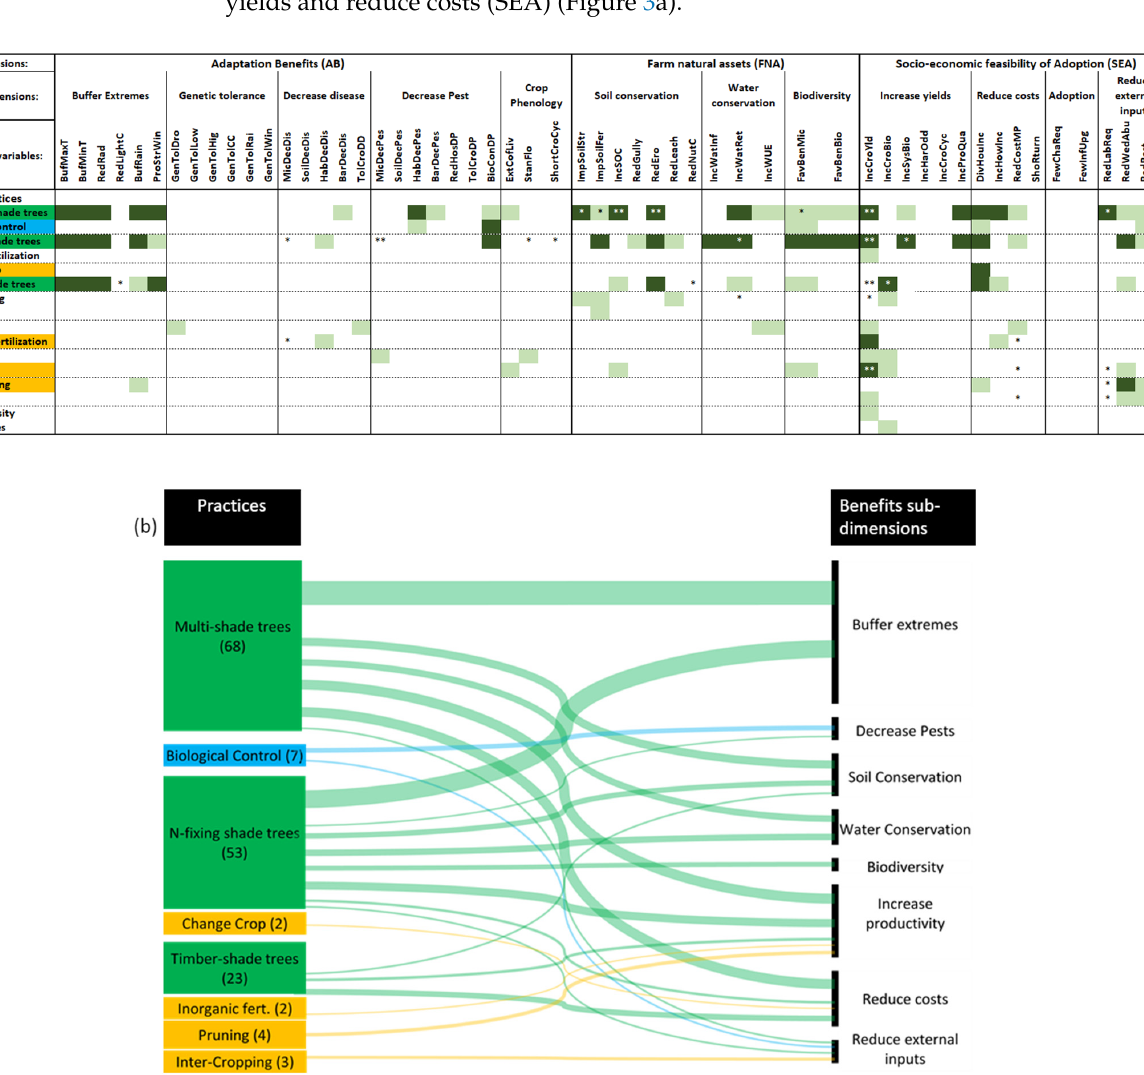
Figure 2. ( a ) Table of records ( n = 221) and knowledge gaps regarding the effects of agricultural practices (first column) on multiple benefits organized by the benefit dimensions and sub-dimensions relevant for coffee smallholder adaptation. Cells in the table show where we found no record of positive effect (empty cells); only one record (light green) or two or more records (darker green). For records of negative effects, the table shows only one record one (*) or two or more records (**). ( b ) Sankey evidence synthesis diagram ( n = 168) visually displays the benefits provided by those practices for which at least two or more records confirmed their positive effects (i.e., darker green cells in the accompanying table).